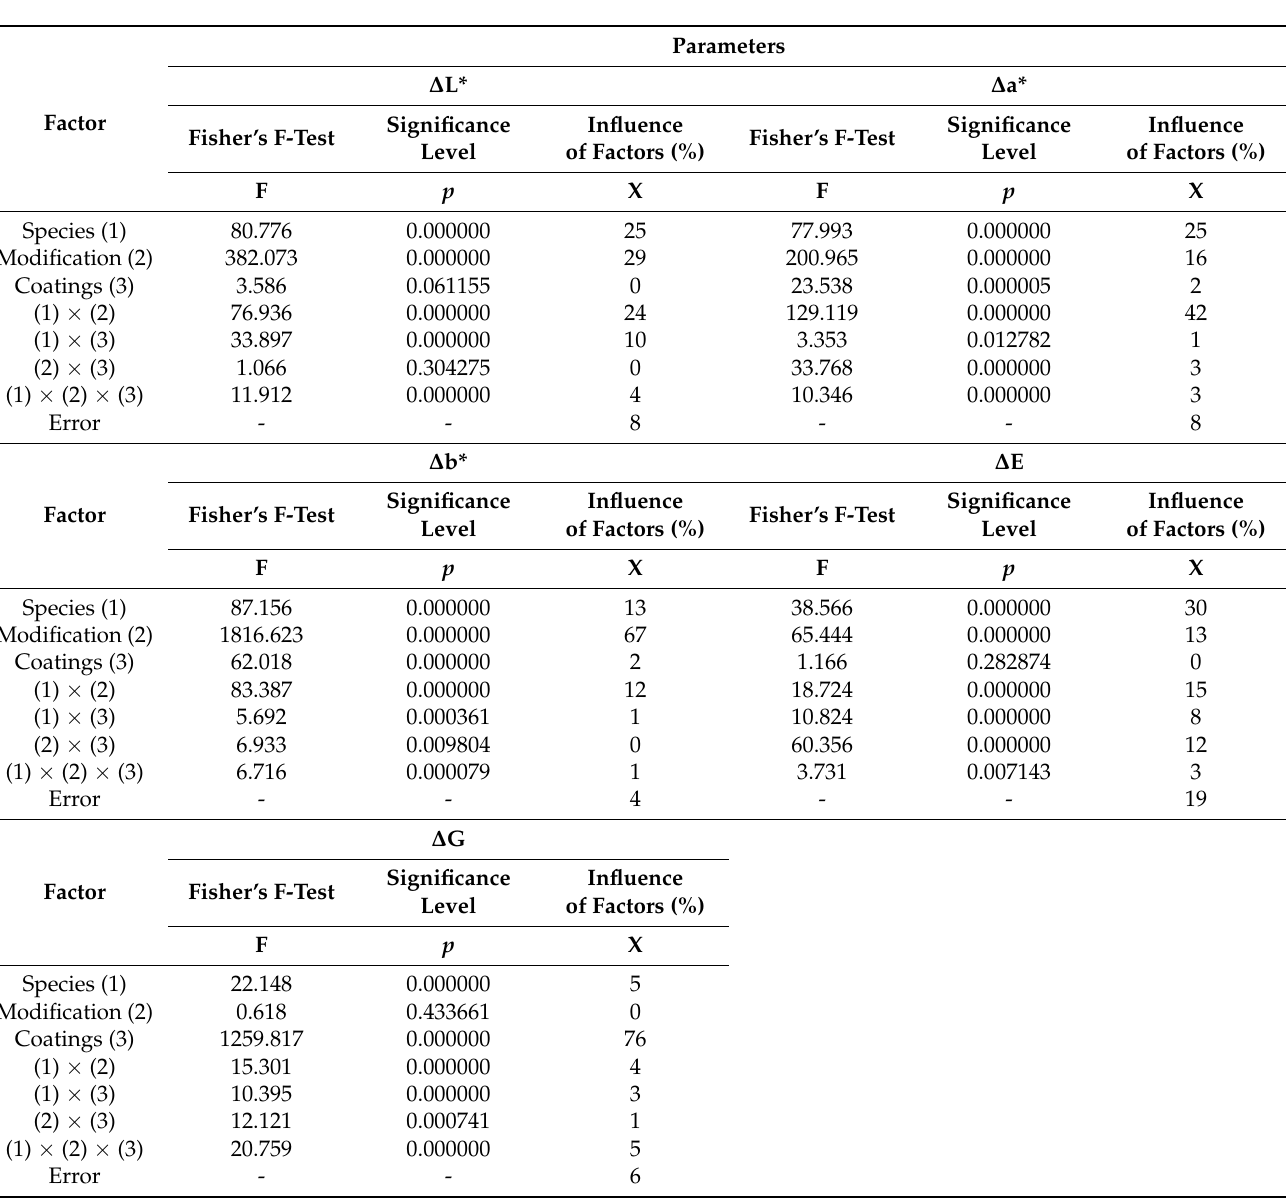
Table 5. The percentual influence of selected factors on the changes of colour parameters ( ∆ L*, ∆ a*, ∆ b*), ∆ E, ∆ G of